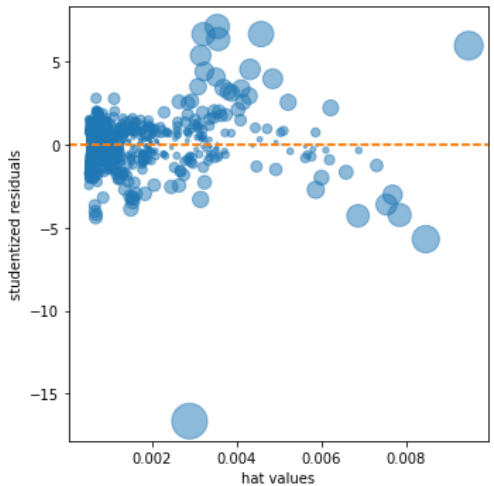
Figure 10. Studentized residuals and hat